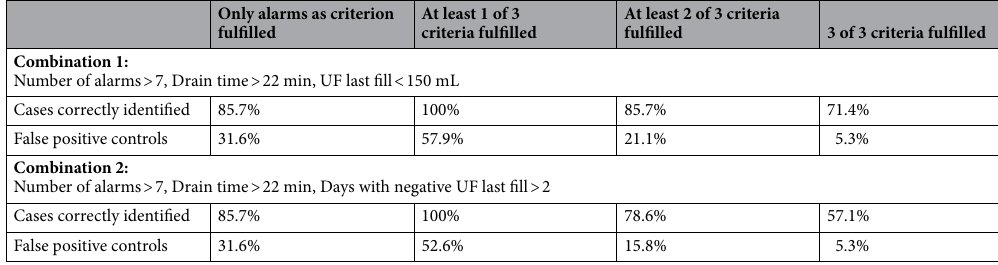
Table 4. Combination of the most promising parameters for identifying patients with catheter dysfunction in the cases and the